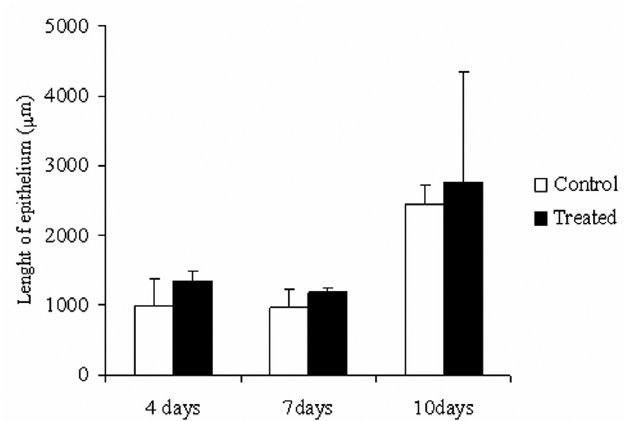
FIGURE 2 - Effect of treatment of cutaneous wounds with ointment containing 1% ethyl-acetate fraction from stem bark of S. adstringens on the length ( m m) of the newly formed epithelium. Mean ± S.D. (n=5) *P<0.05 compared to the control.